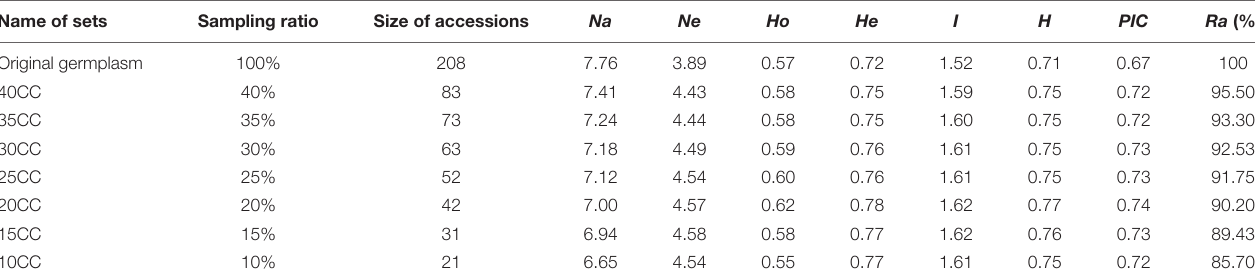
FIGURE 3 | The population structure analysis of 208 A. biserrata samples collected from three locations. (A) The UPGMA cluster analysis. Light pink, blue and purple colors corresponding to the Puling (PL001-070), Gaofeng (GF071-139), and Langping (LP140-208) populations, respectively. The light green and yellow blocks explain two clustering groups. (B) The principal coordinate analysis (PCoA). The light pink, blue and purple dots represent samples collected from the Puling, Gaofeng, and Langping locations, respectively. The orange dot explains the distribution of the core collection materials in the original germplasm. (C) The population structure of A. biserrata when K = 2. Green color explains the first genetic group mainly including samples from the Puling and Gaofeng locations, while red represents the other genetic group with samples from Langping. TABLE 2 | The characteristic in genetic diversity of original germplasm and seven preliminary core collections under different sampling